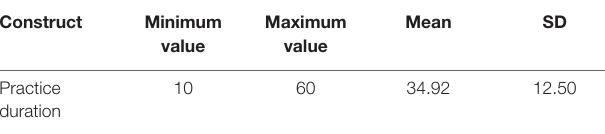
TABLE 3 | Analysis of the average number of weekly practices in